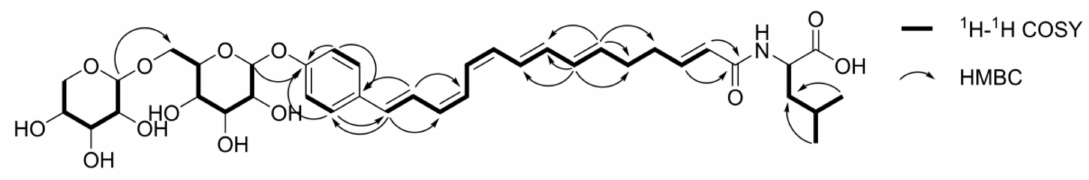
Figure 3. Key 1 H- 1 H COSY and HMBC correlations of compound 1